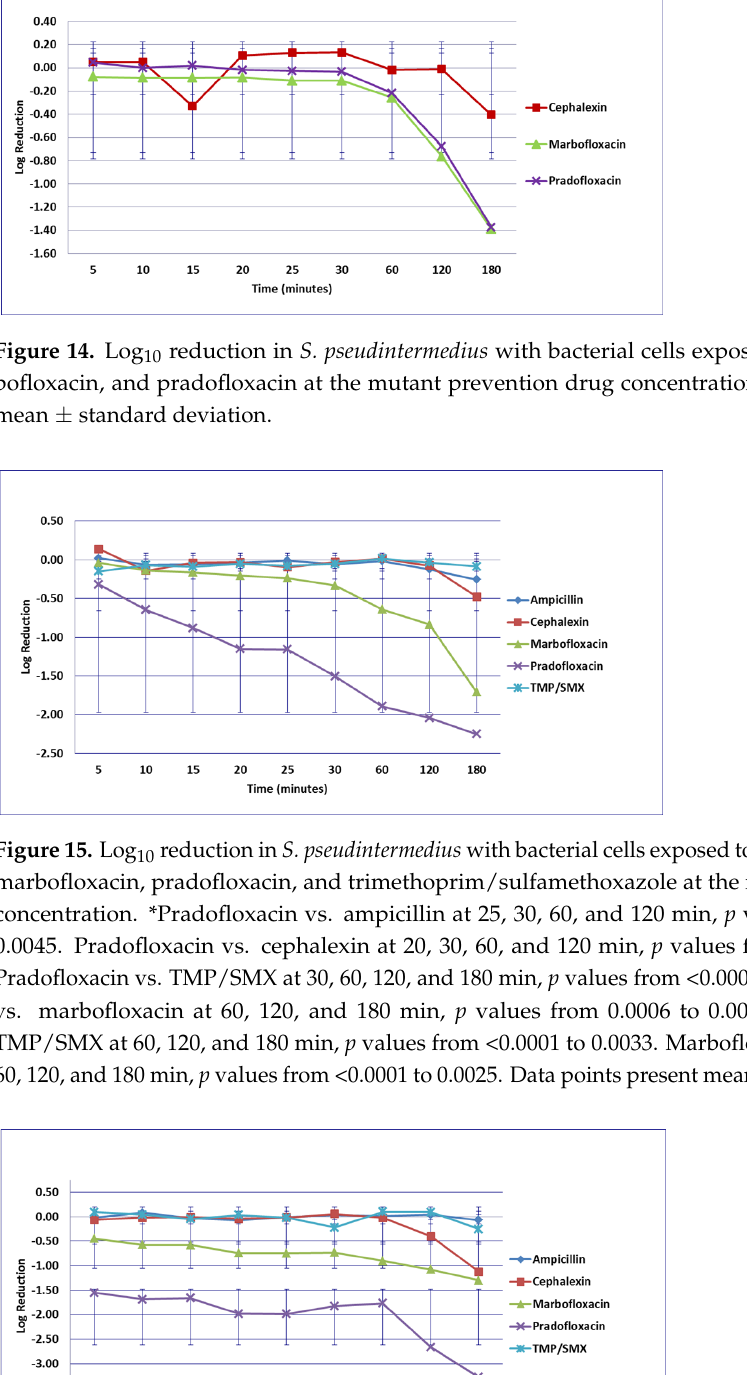
Figure 13. Log 10 reduction in S. pseudintermedius with bacterial cells exposed to ampicillin, cephalexin, marbofloxacin, pradofloxacin, and trimethoprim/sulfamethoxazole at the minimum in- hibitory drug concentration. Data points present mean ± standard deviation.